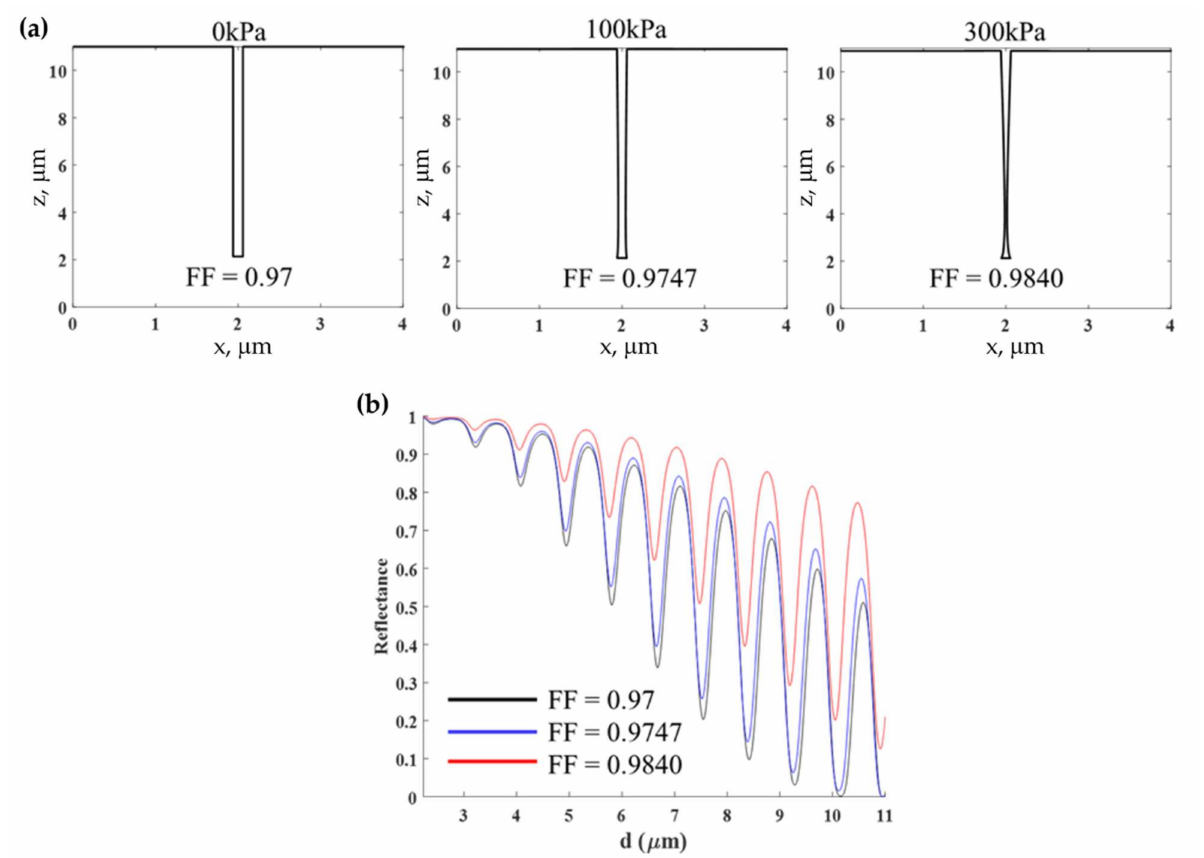
Figure 13. ( a ) Structural deformation when illuminated by different ultrasonic pressures calculated using the FEM, and ( b ) reflectance corresponding to the F.F. values in Figure 13a calculated using RCWA for the PDMS grating with λ g of 4 µ m, F.F. of 0.97, and d g of 8.87 µ